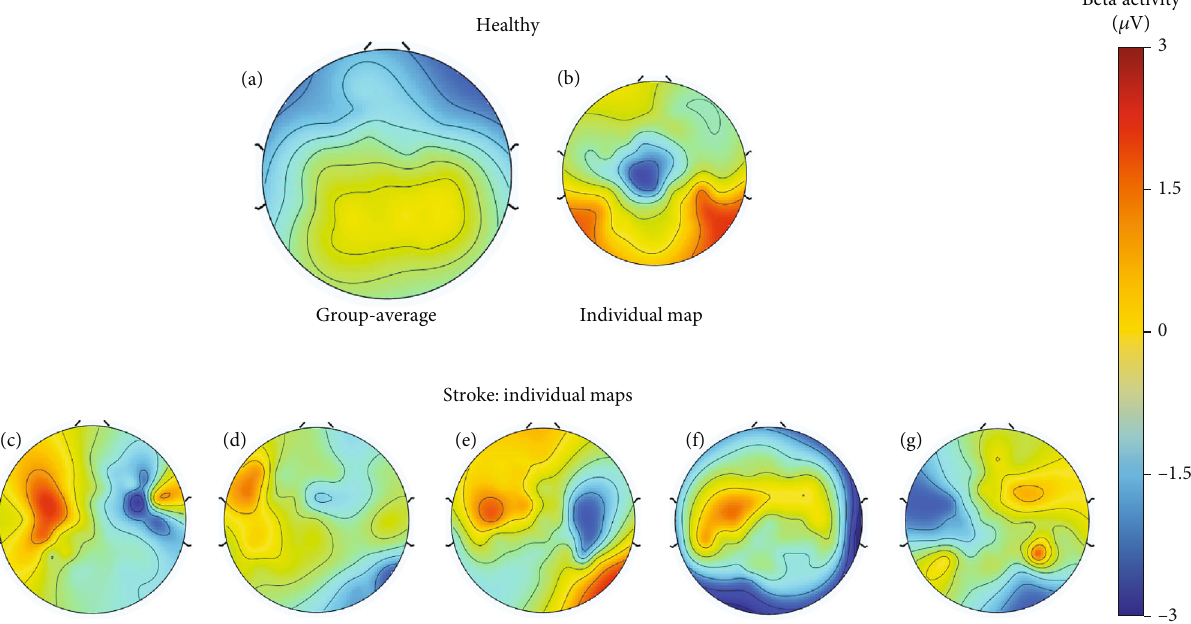
Figure 4: Grand-average topographical distribution for the beta rhythm of the control group (a), an example of an individual map from a healthy participant (b), and examples of individual maps for patients with a stroke lesion in the left (c – f) and right (g) hemispheres, during thumb opposition of both hands simultaneously. In each scalp map, red indicates synchronization, while blue is representing the